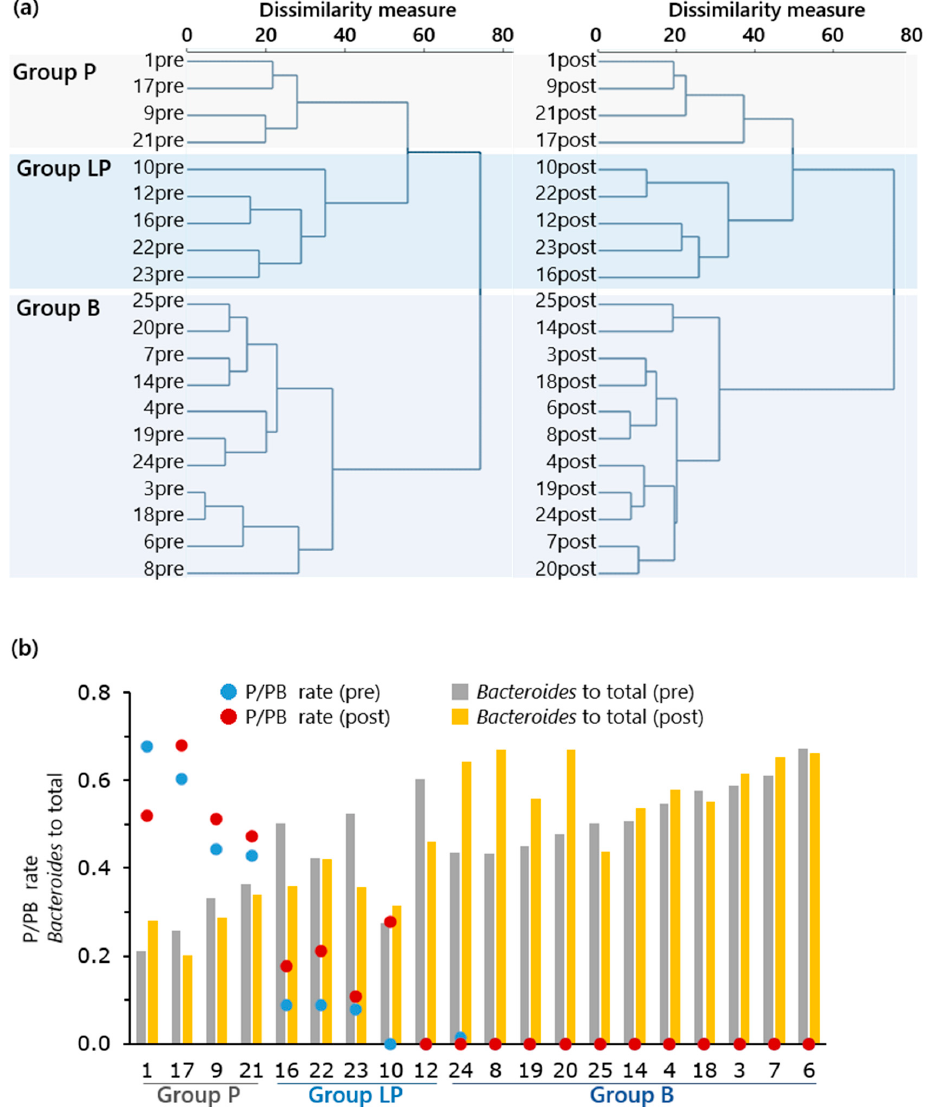
Figure 2. Grouping based on stool microbiota structure. ( a ) Cluster dendrogram of T-RFLP fragment patterns of the stool microbiota structure of subjects sampled twice (pre-ingestion (left) and post-ingestion (right)) separately, based on relative proportions of fragment three distinctive groups. ( b ) Sorting of the subjects based on stool Prevotella proportion to the sum of Prevotella and Bacteroides (P/PB ratio). Two bars for each subject are relative proportions of Bacteroides to total (gray bar, pre-ingestion; yellow bar, post-ingestion). This sorting also well reflected the natures of 3 groups: Group P (high Prevotella proportion), group LP (low or zero Prevotella , and high Clostridium cluster IV and Clostridium subcluster XIVa), and group B (low Clostridium cluster IV and Clostridium subcluster XIVa, and high Bacteroides ).